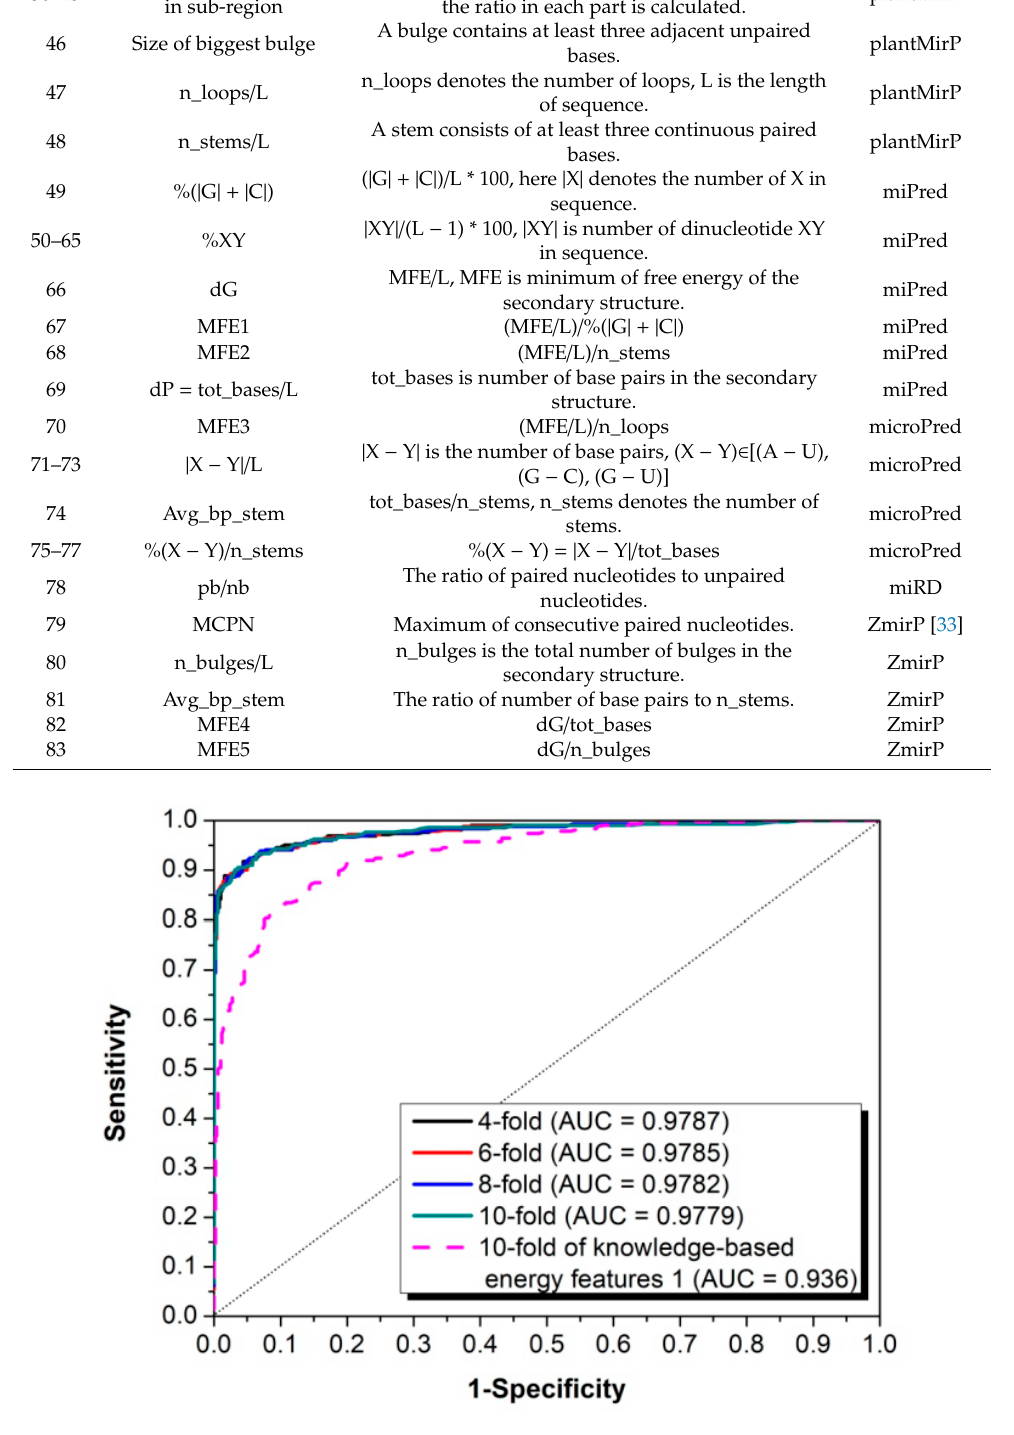
Figure 3. Sensitivity (Se), specificity (Sp), accuracy (Ac), and Matthew’s correlation coefficient (MCC) of riceMirP based on independent (unseen) testing dataset.